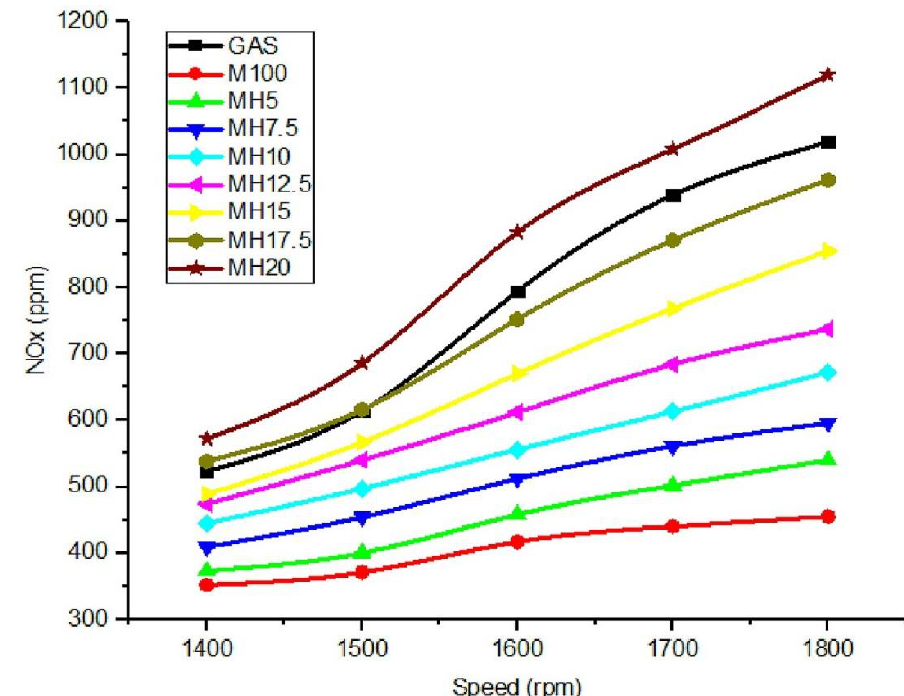
Figure 19. Increase of NO x emissions using hydrogen fuel in gasoline engines [85].